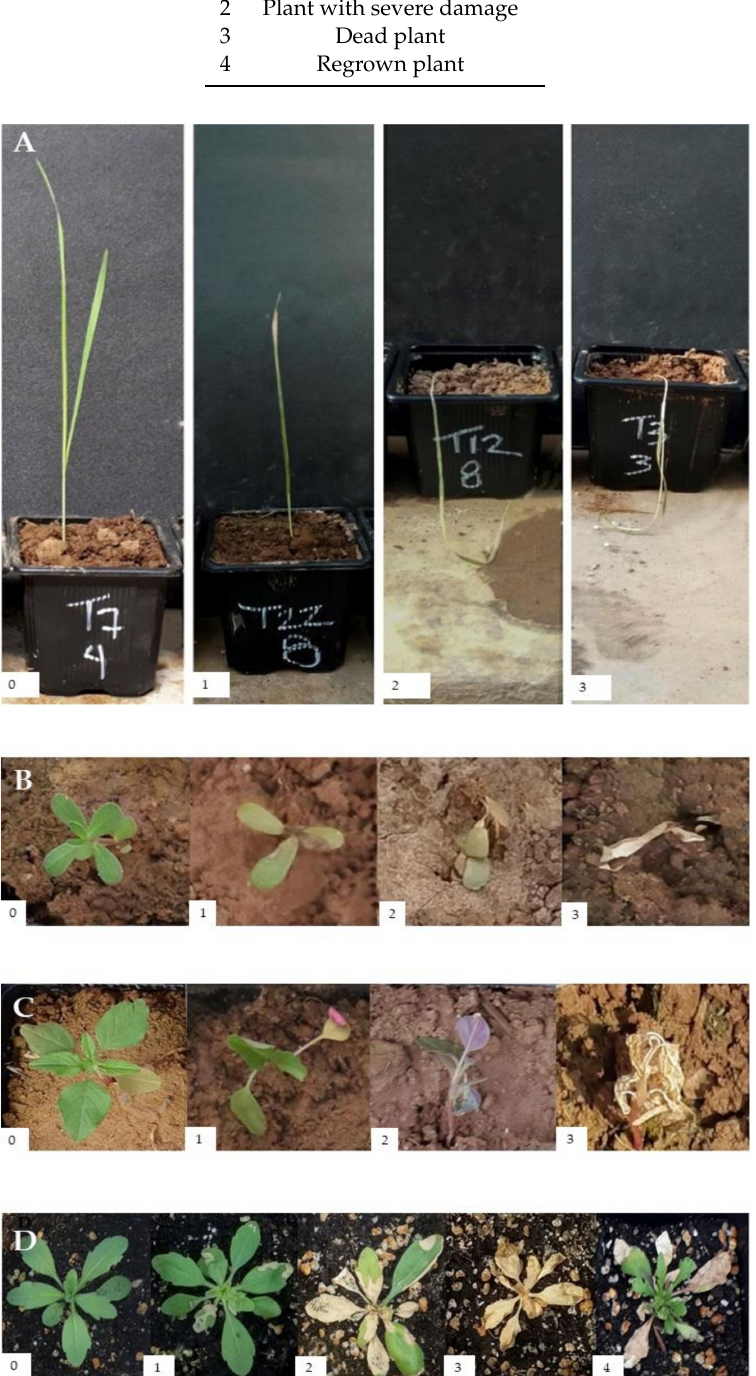
Figure 3. Damage scale for each species: ( A ) A. fatua , ( B ) P. oleracea , ( C ) A. retroflexus , and ( D ) E. bonariensis